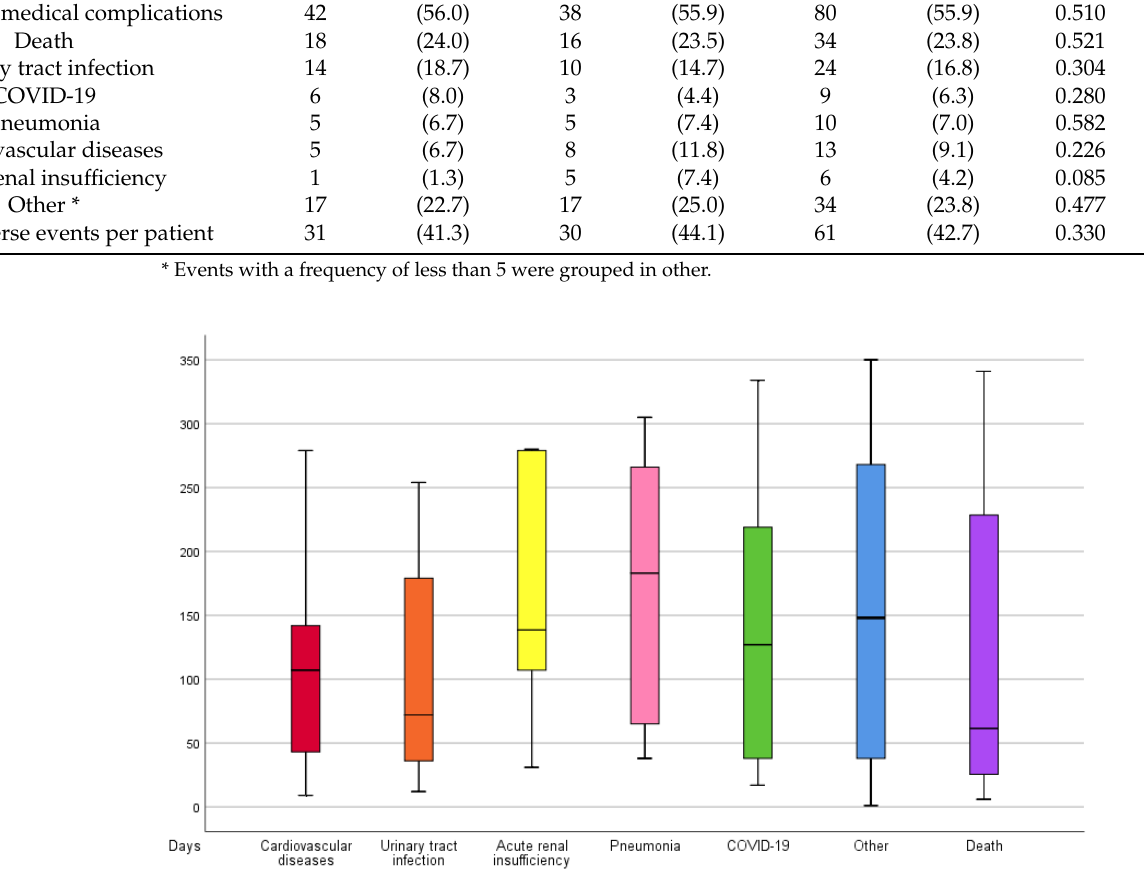
Figure 2. Time to complications after hospital discharge in days.